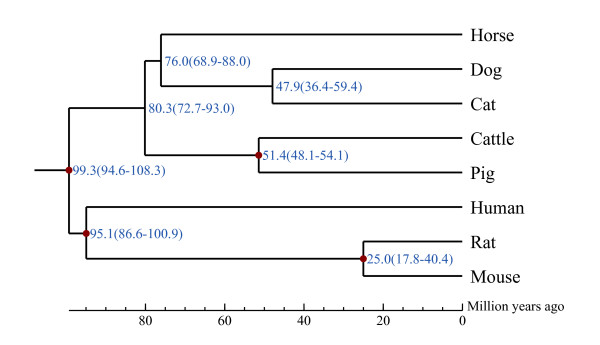
Estimation of divergence time. The time of divergence (with error range shown in parentheses) of pig and seven other mammals based on orthology relationships. Distances are shown in millions of years.